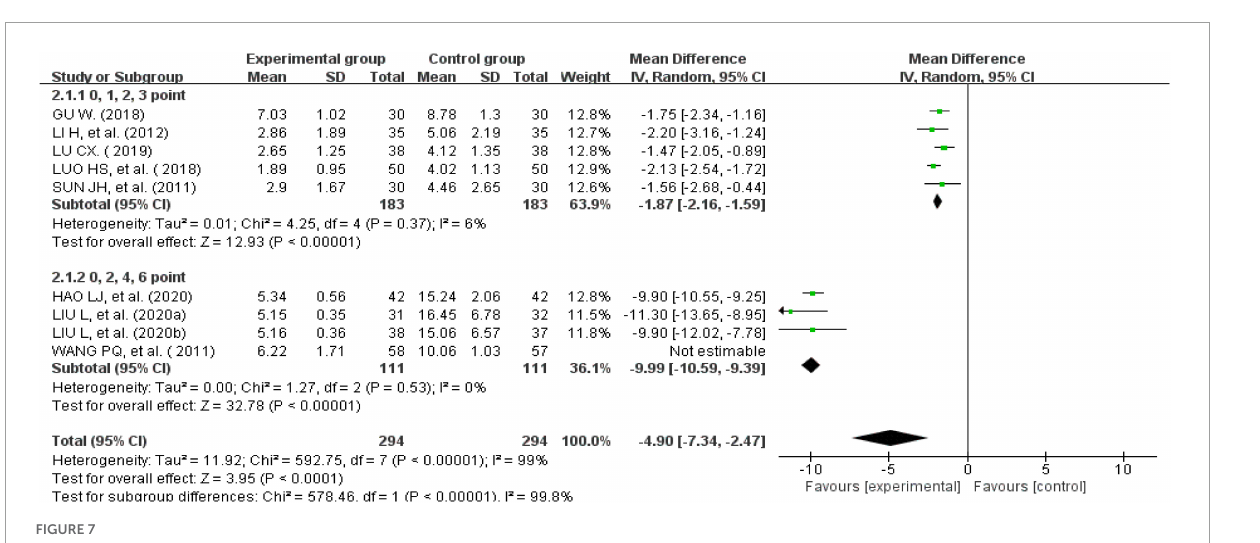
FIGURE7 Forest plot of the total symptom score.